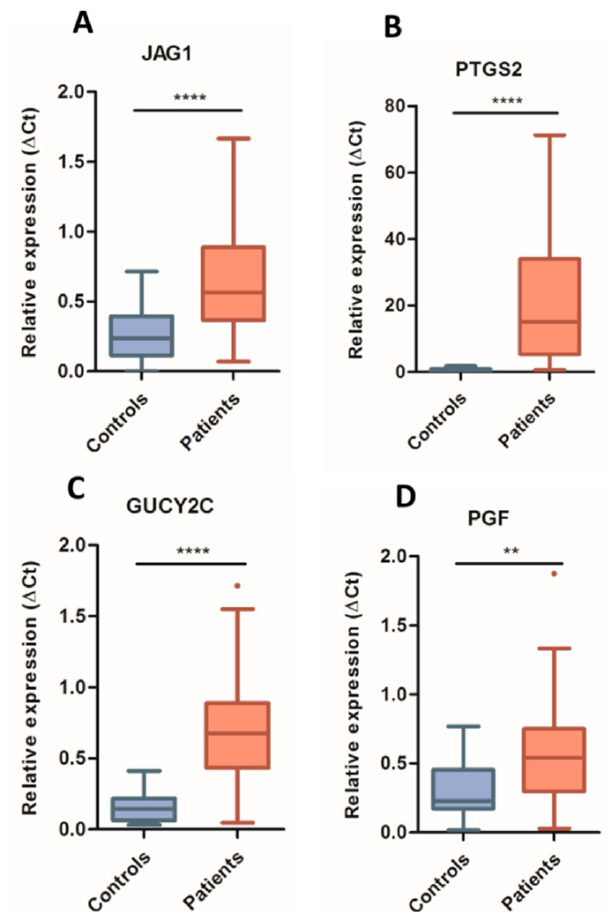
Figure 2. Relative quantification of gene expression levels by digital PCR in serum samples. Expression levels of JAG1 ( A ), PTGS2 ( B ), GUCY2C ( C ) and PGF ( D ) genes were determined in serum from metastatic colon cancer patients (red) and healthy controls (blue), normalized by MTR expression and calculated by the ∆ Ct method. In box plots, boxes show the interquartile range (IQR), whiskers indicate Q1-1.5xIQR and Q3 + 1.5xIQR values, inner lines indicate medians. (**) p < 0.01; (****) p < 0.0001; (ns) not significant.